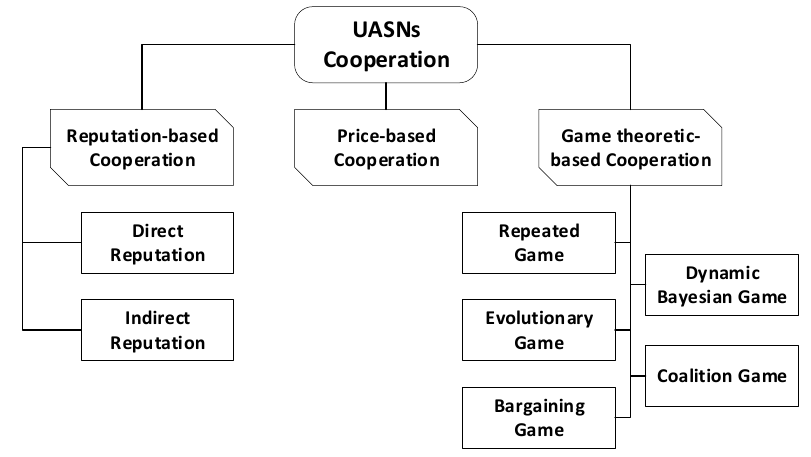
Figure 5. Taxonomy of cooperation in UASNs.